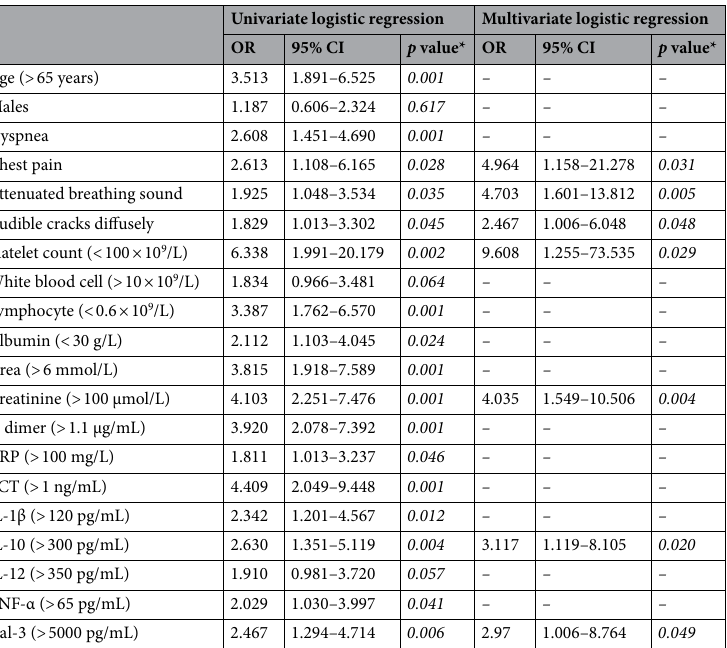
Table 5. Factors associated with critical stage of COVID-19. Significant values are in italics. *p value < 0.05 was considered statistically